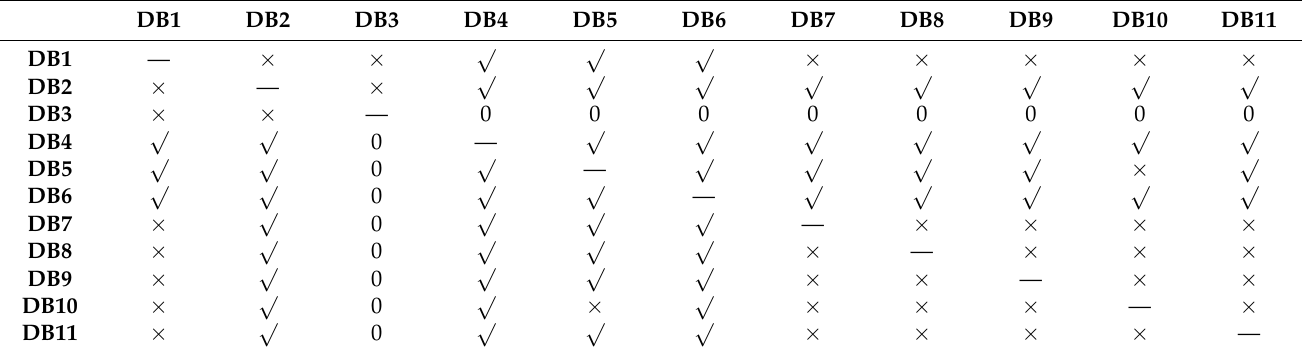
Table 1. Compatibility and mutual exclusion of different